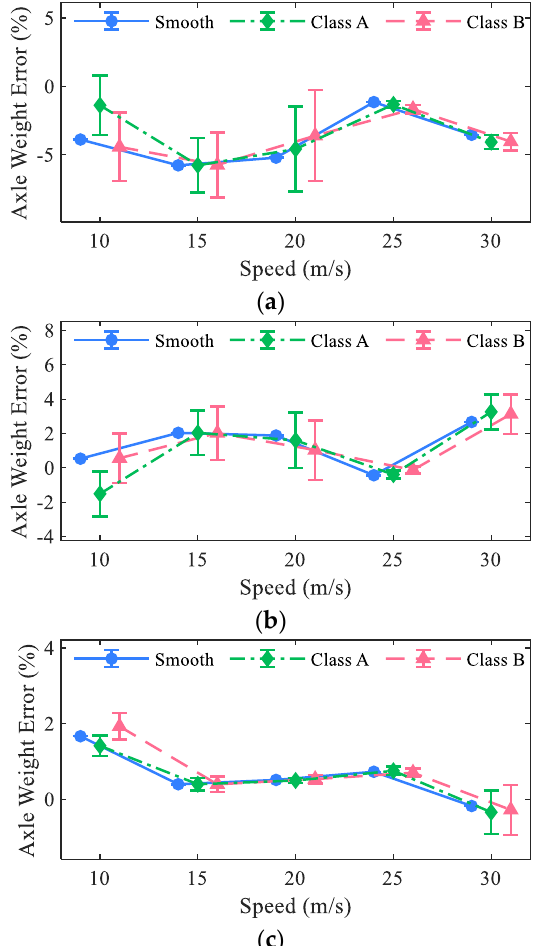
Figure 10. Identified axle weight error of the 5-axle truck: ( a ) first axle, ( b ) second axle, and ( c ) tail axle group.